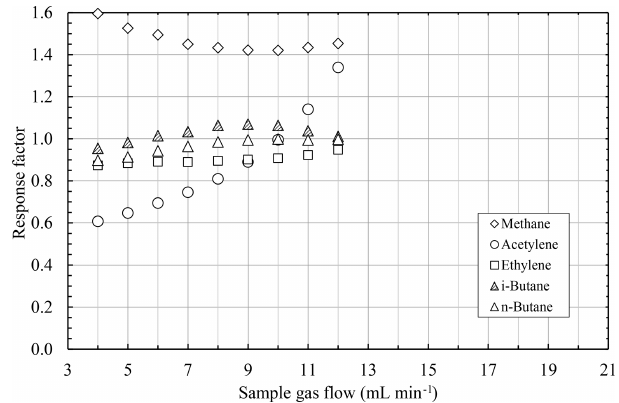
Figure 8. Response factors of different hydrocarbons as a func- tion of the sample gas flow at a constant burning gas flow of 12mLmin − 1 H 2 and 6mLmin − 1 O 2 .